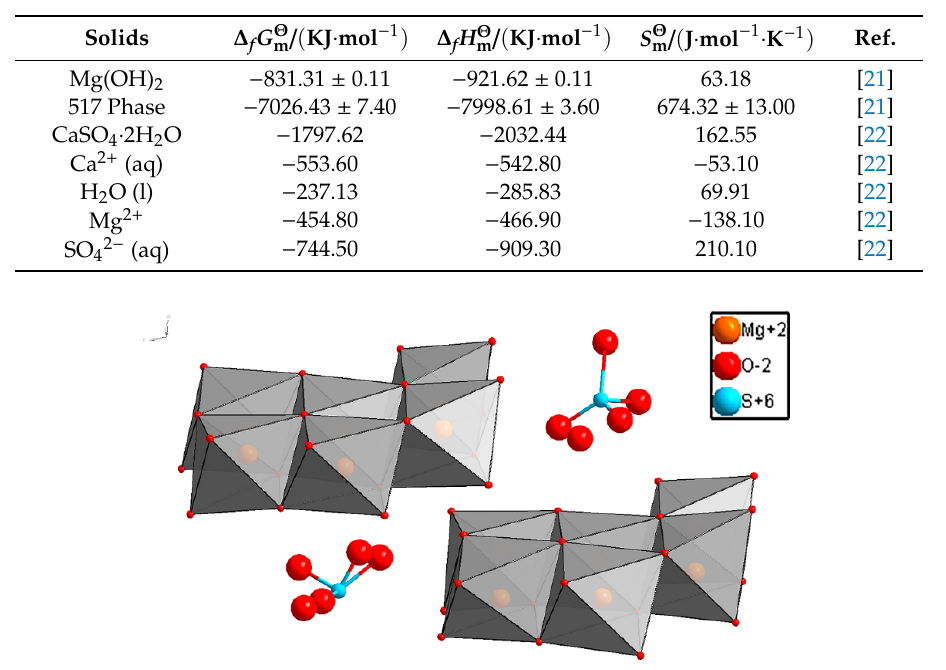
Table 3. Standard molar thermodynamic properties of solid phases at 298.15 K.